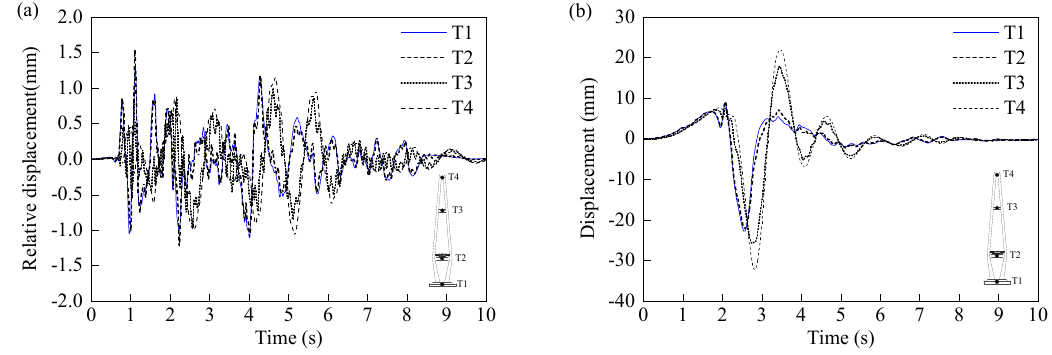
Figure 15. Displacement time history response of 3# tower ( a ) under ScEL; ( b ) under ScTCU.